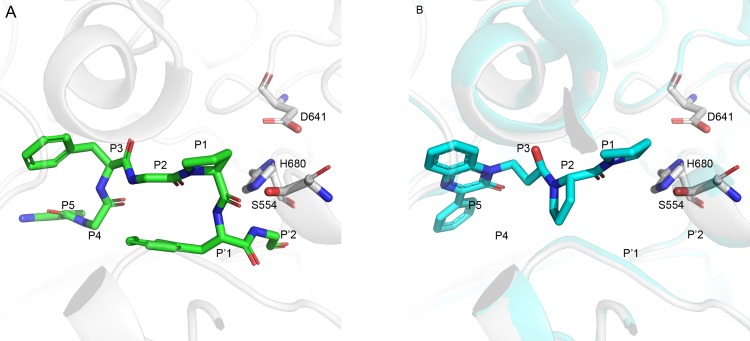
Substrate and inhibitor positions in the active site of POP.A) The substrate from structure 1E8N with Ala554 replaced by Ser so as to present its ability to attack the carbonyl of P1 for cleaving P1-P1'. B) An inhibitor positioned at the active site while its P1-P1' positions have been erased. Substrate and inhibitor are presented as green and cyan sticks, respectively and enzyme elements are in pale gray.